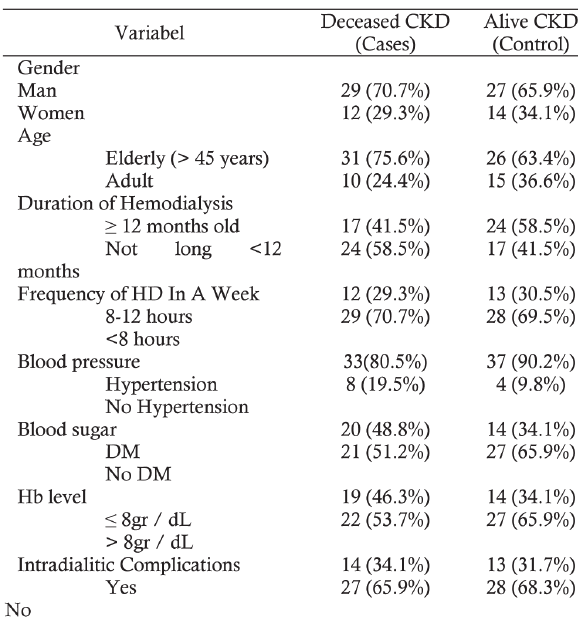
Table 1. Characteristics of CKD